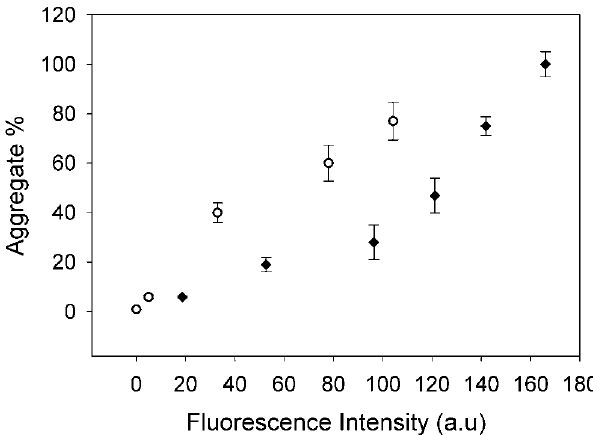
Figure 5. Correlation between percentage of aggregated species and ThT-binding fluorescence. Percentage of aggregated species (non-dimer), determined by light scattering measurements, vs ThT-binding fluorescence for apo WT SOD1 (O) and apo I113T SOD1 ( ¤ ) during the incubation of the samples at 37 u C. Error bars are derived from the molecular mass errors of the light scattering experiments.